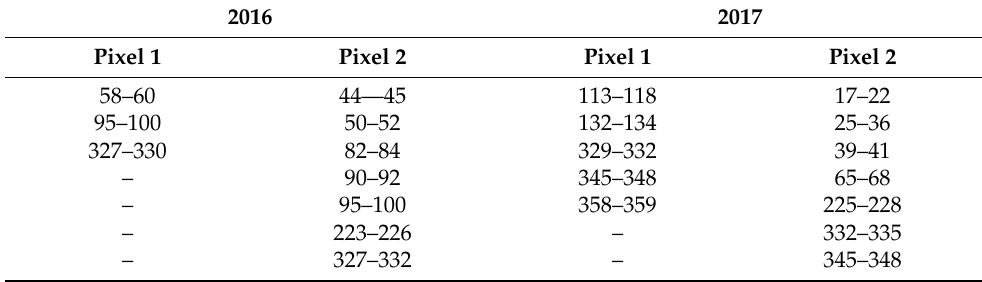
Table 4. Start and end times (day of year) of extracted irrigation signals in Hebi City at two